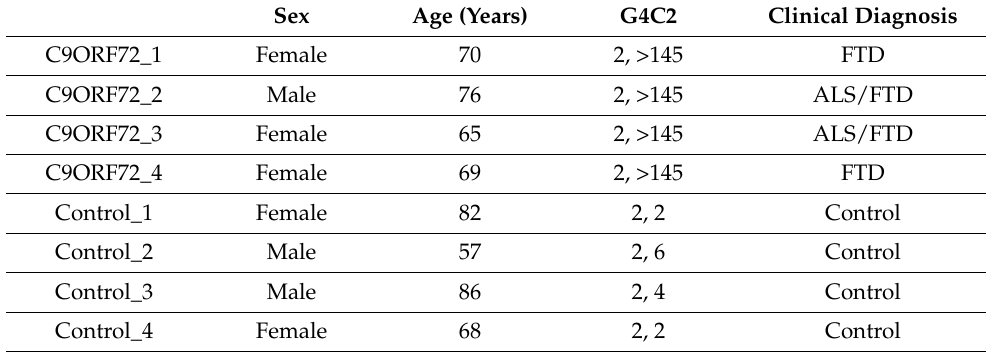
Table 1. Clinical and molecular characterization of the patients and controls included in the